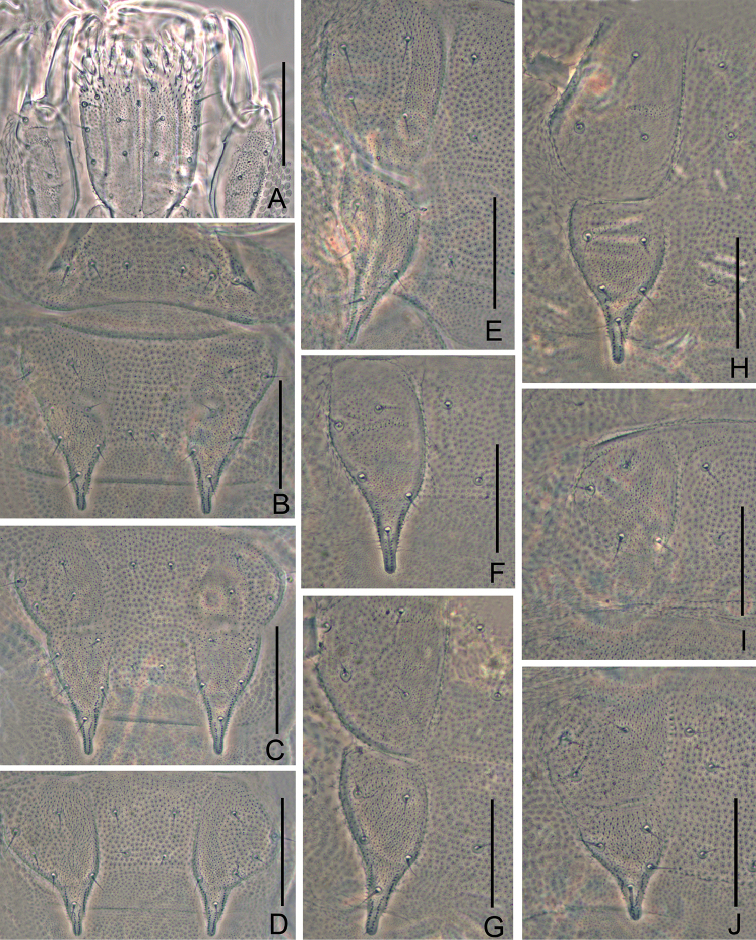
Scolopendrellopsisglabrus sp. n. (Holotype) A first and second maxilla B 1st and 2nd tergite C 3rd tergite D 4th tergite E 6th tergite, left side F 8th tergite, left side G 9th tergite, left side H 12th tergite, left side I 14th tergite, left side J 15th tergite, left side. Scale bars: 20 μm.